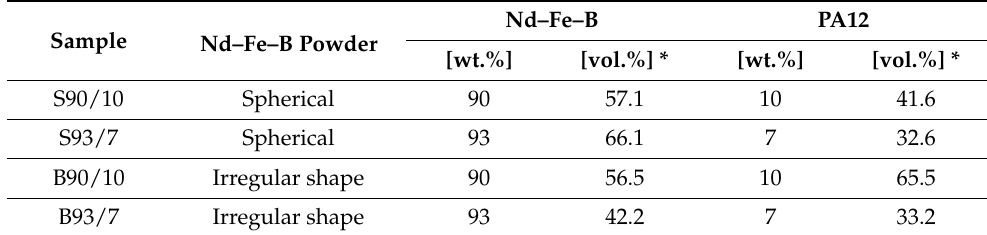
Table 2. Composition of the prepared filaments.